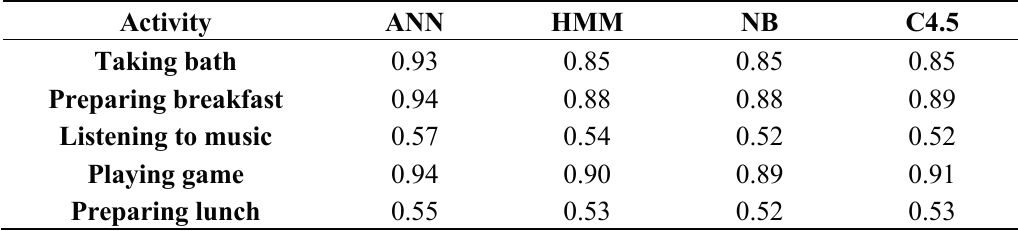
Table 5. Activity recognition with data of two